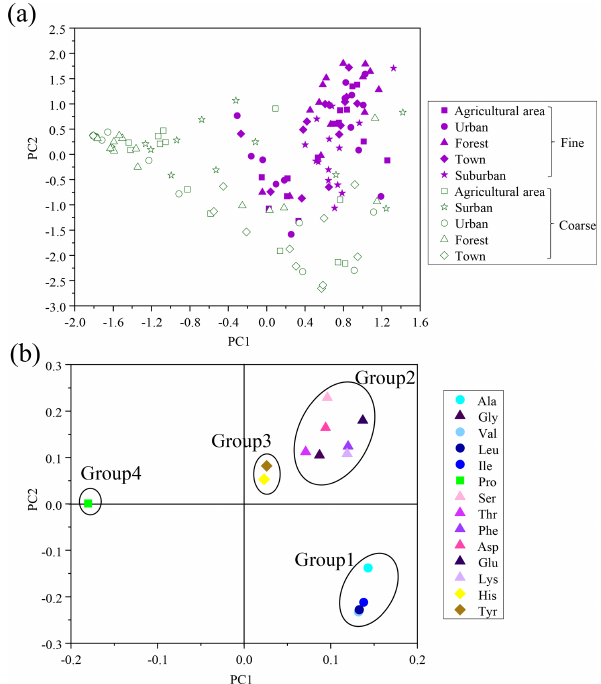
Figure 5. (a) Cross plot of the first and second component scores of PCA based on percentage composition (Mol%) of hydrolyzed amino acid for fine and coarse particles. (b) Cross plot of factor coefficients of the first and second principal components of PCA. The lines enclosing each group of amino acid are arbitrarily